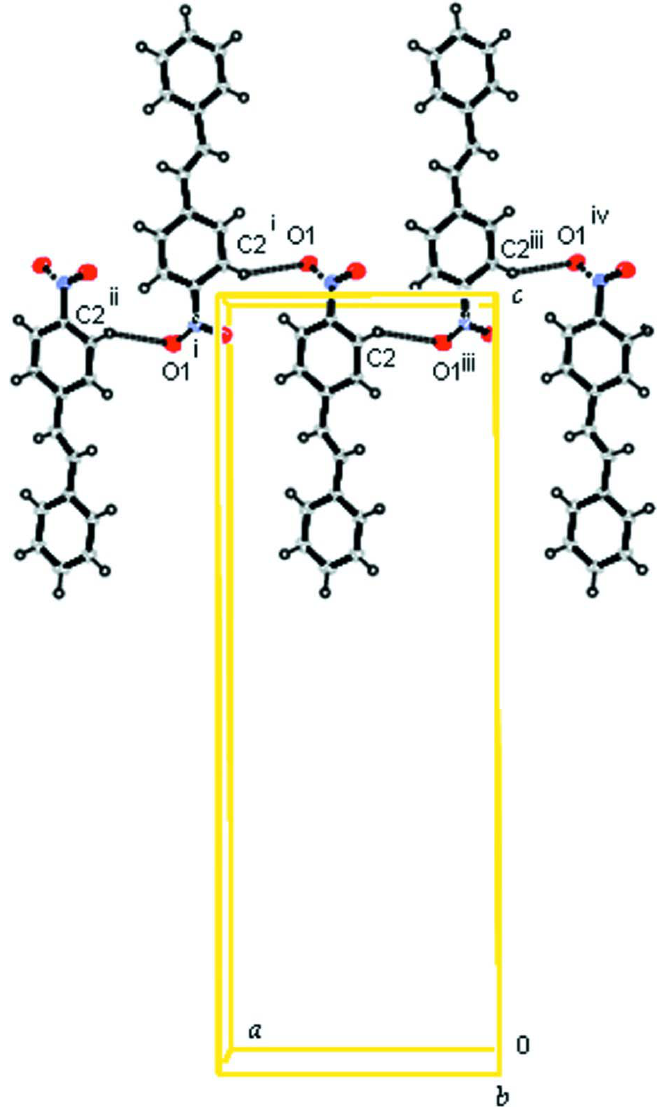
(Part of the crystal structure of (I) showing the formation of C (5) chains which are running parallel to the [100] direction. [Symmetry codes: (i) 1/2 + x , 1/2 - y , 2 - z ; (ii) 1 + x , y , z ; (iii) -1/2 + x , 1/2 - y , 2 - z ; (iv) -1 + x , y , z